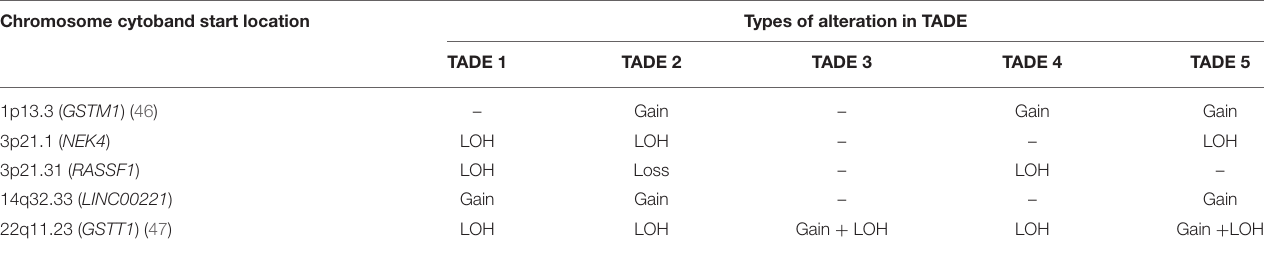
TABLE 2 | Genetic alterations on the same chromosomal location common to at least two TADE. Chromosome cytoband start location